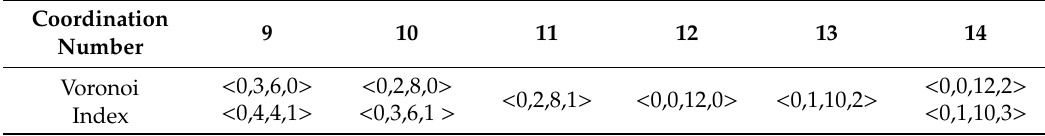
Figure 2. Planar projection reflecting the shell atom connection modes of Voronoi indexed clusters. ( a ) The planar projection of < 0,0,12,0 > ; ( b ), ( c ) Two types of planar projection of < 0,2,8,2 > ; ( d )–( h ) Five types of planar projection of < 0,4,4,4 > . Table 1. Voronoi clusters with only one type of planar projection.